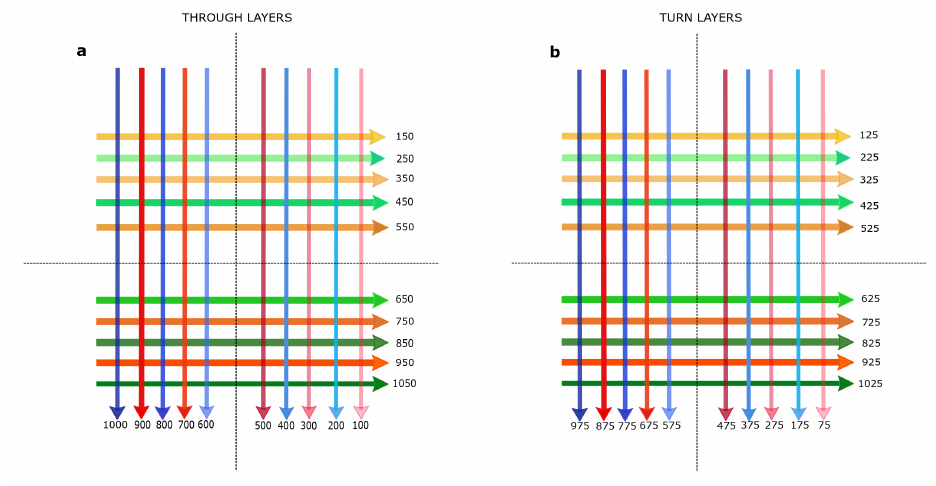
Figure 5. Traffic flow at a typical four-leg intersection for the one-way airspace concept. The traffic is vertically segmented into different altitudes with respect to their travel direction. Note that the altitudes are presented in ft. ( a ) Traffic flows belonging to the through-layers, which consist of 20 layers in total. ( b ) Traffic flows of the turn-layers, which consist of a total of 20 layers. The through-layers accommodate traffic that pass through at least one intersection, while turn-layers accommodate traffic that is decelerating to make a turn at the intersection. Note that opposite traffic flows do not intersect at the